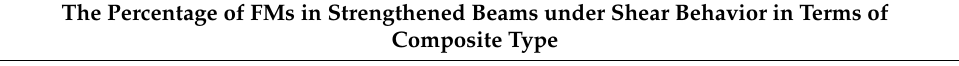
Table 9. The Percentage of FMs in strengthened beams under shear behavior in terms of composite